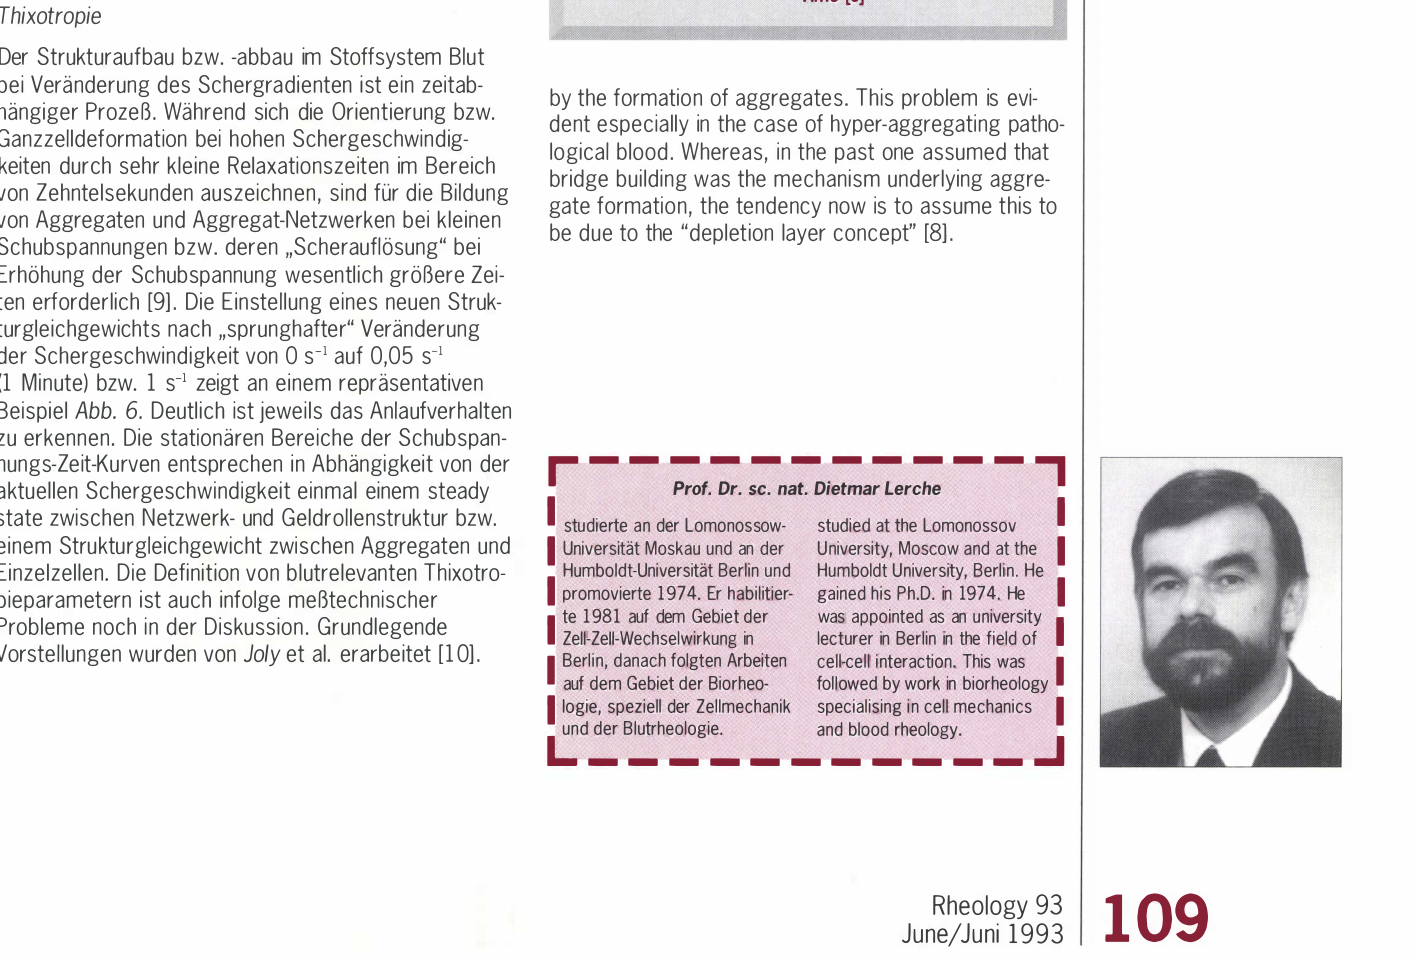
bridge building was the mechanism underlying aggre­